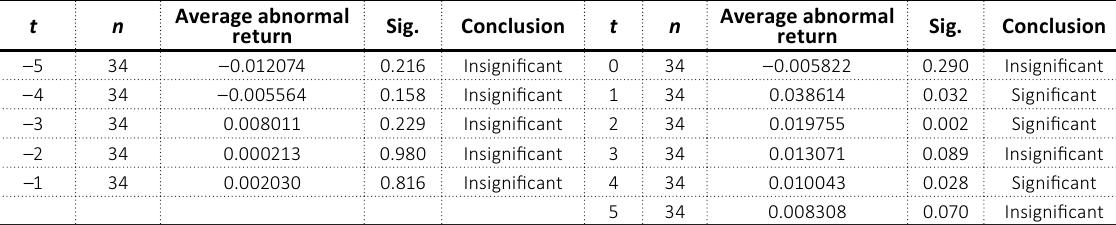
Source: Result of the